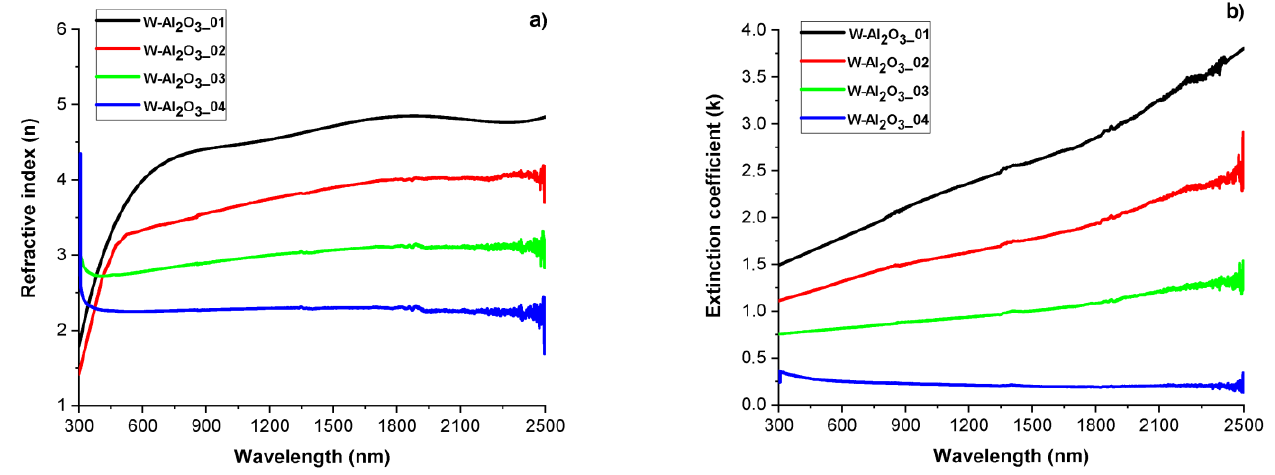
Figure 7. Optical parameters of realized cermet: ( a ) refractive index; ( b ) extinction coefficient. Table 2. Process parameters and thickness evaluations for cermet samples obtained by varying the power density applied to the W target and keeping a fixed power density applied to the Al targets.